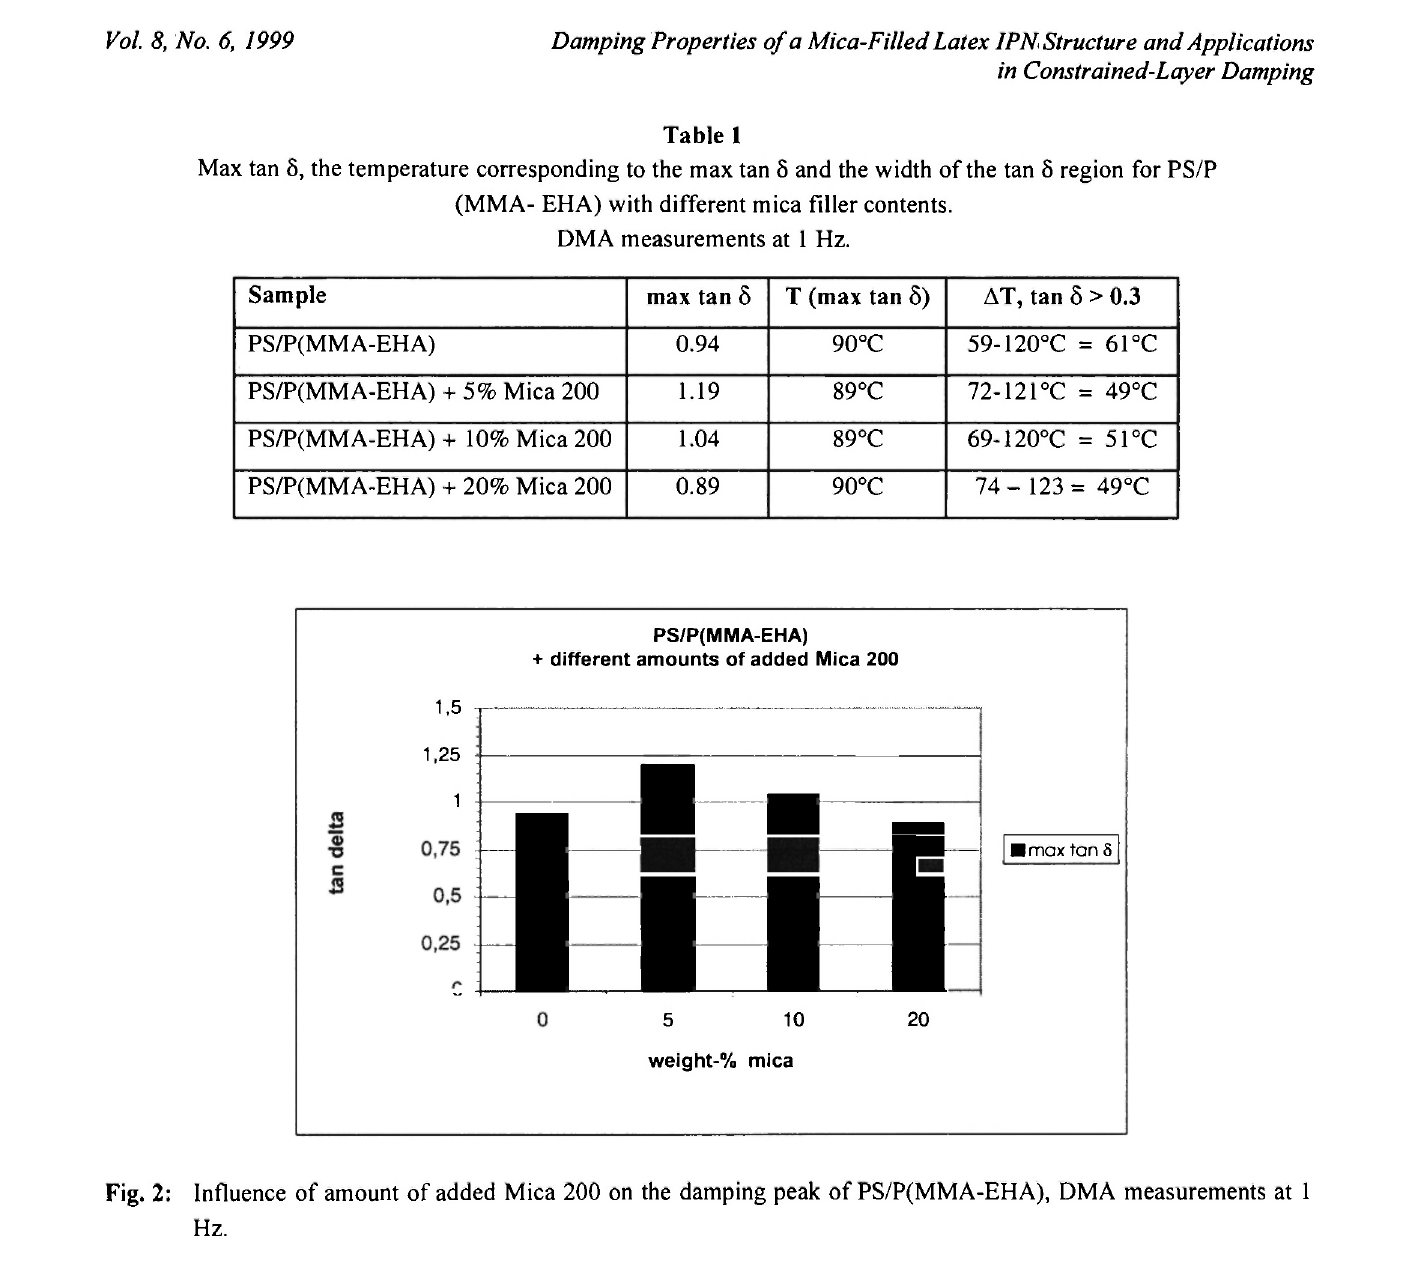
Fig. 2: Influence of amount of added Mica 200 on the damping peak of PS/P(MMA-EHA), DMA measurements at 1